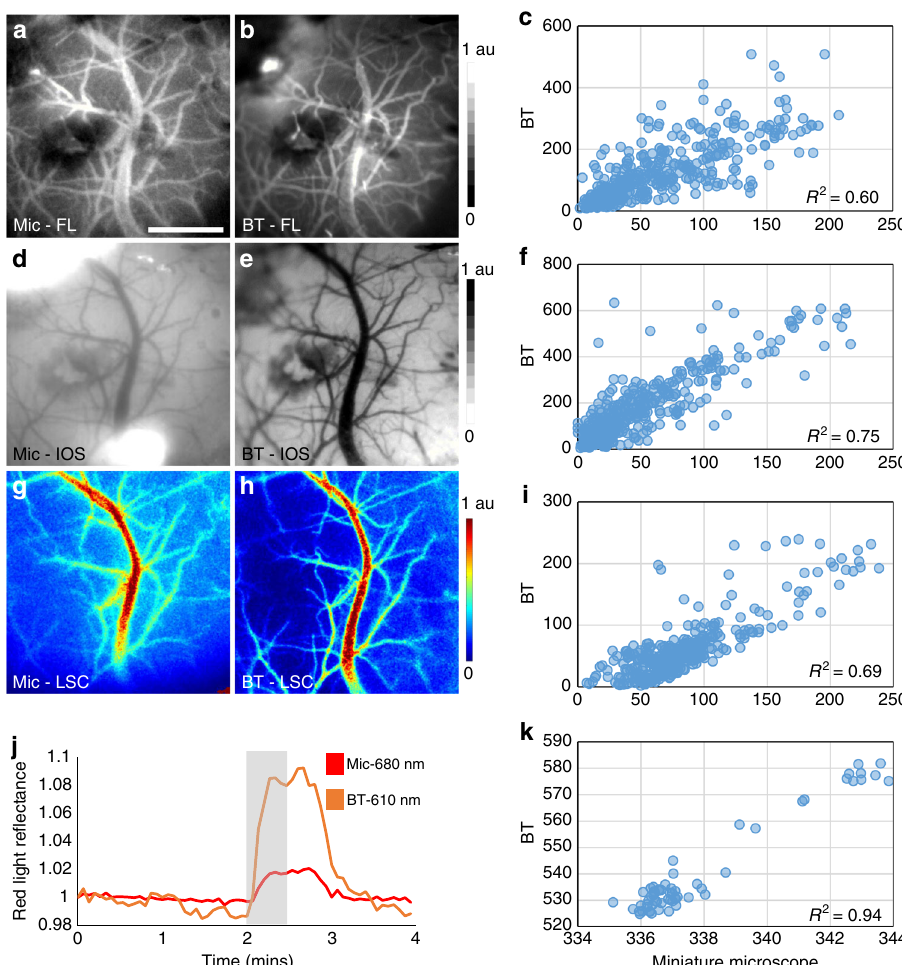
Fig. 2 Performance was comparable to a similar benchtop imaging system. Multi-contrast images of a mouse brain acquired using our microscope (Mic) and a similarly equipped benchtop (BT) imaging system were compared. a , b A network of cerebral microvessels visualized with fl uorescence imaging (FL) following a tail vein injection of dextran-FITC. d , e The same FoV imaged under green light illumination (IOS) illustrating HbT (or CBV) distribution. g , h Pseudo-colored maps of CBF obtained by performing laser speckle contrast imaging under laser illumination (LSC). j Time courses of the dHb- dependent red light re fl ectance from a central 20×20 pixel FoV showing the temporal response to an oxygen inhalation challenge (i.e., inhalation of 100% O 2 for 30 s starting at 2 mins, followed by room air for the remainder of the experiment). c , f , i , k Scatter plots of the post-processed in vivo BT vs. Mic measurements shown in a – h, axes are signal intensity in arbitrary units (a.u.). Spatial correlations were computed for a 20 × 20 pixel grid superimposed over a central 400×400 region. Data presented is from a single animal and scale bar indicates 1